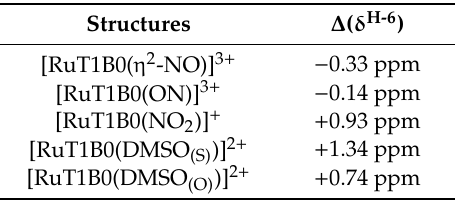
Table 2. Relative chemical shift of protons in position 6 on the bipyridine ligands with respect to the A form of complex [RuT1B0(NO)] 3 + .